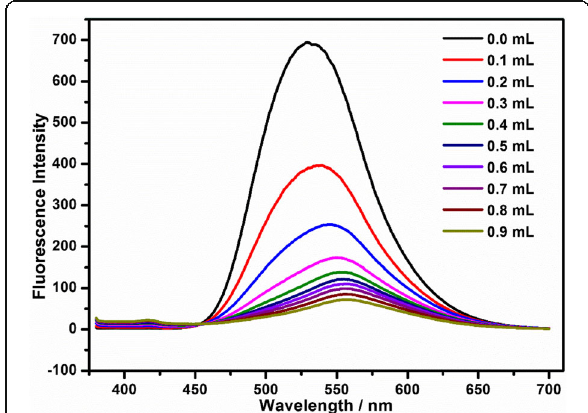
Fig. 6 The PL spectra of aqueous solution (3 mol/L OH ˉ ) (2 mL) of BMIP (1 mmol/L) after the addition of different volumes (0, 0.1, 0.2, 0.3, 0.4, 0.5, 0.6, 0.7, 0.8, and 0.9 mL, respectively) of NaOH solution (3